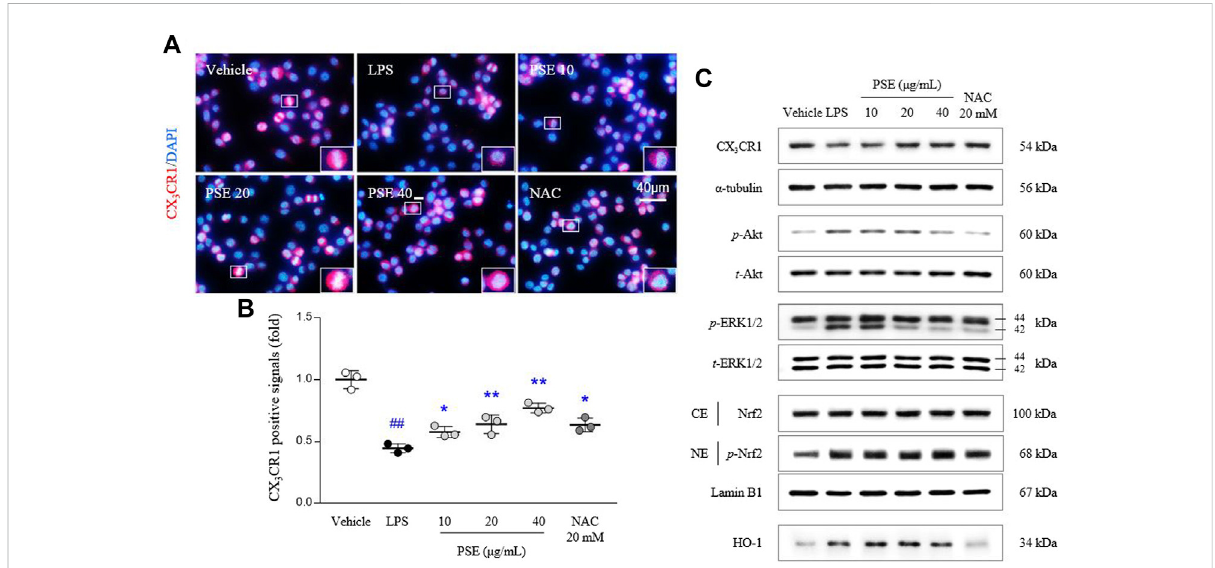
FIGURE 3 CX3CR1 signals and its related protein expressions. CX 3 CR1 fl uorescence signals were semiquanti fi ed (A,B) , and protein expression levels of